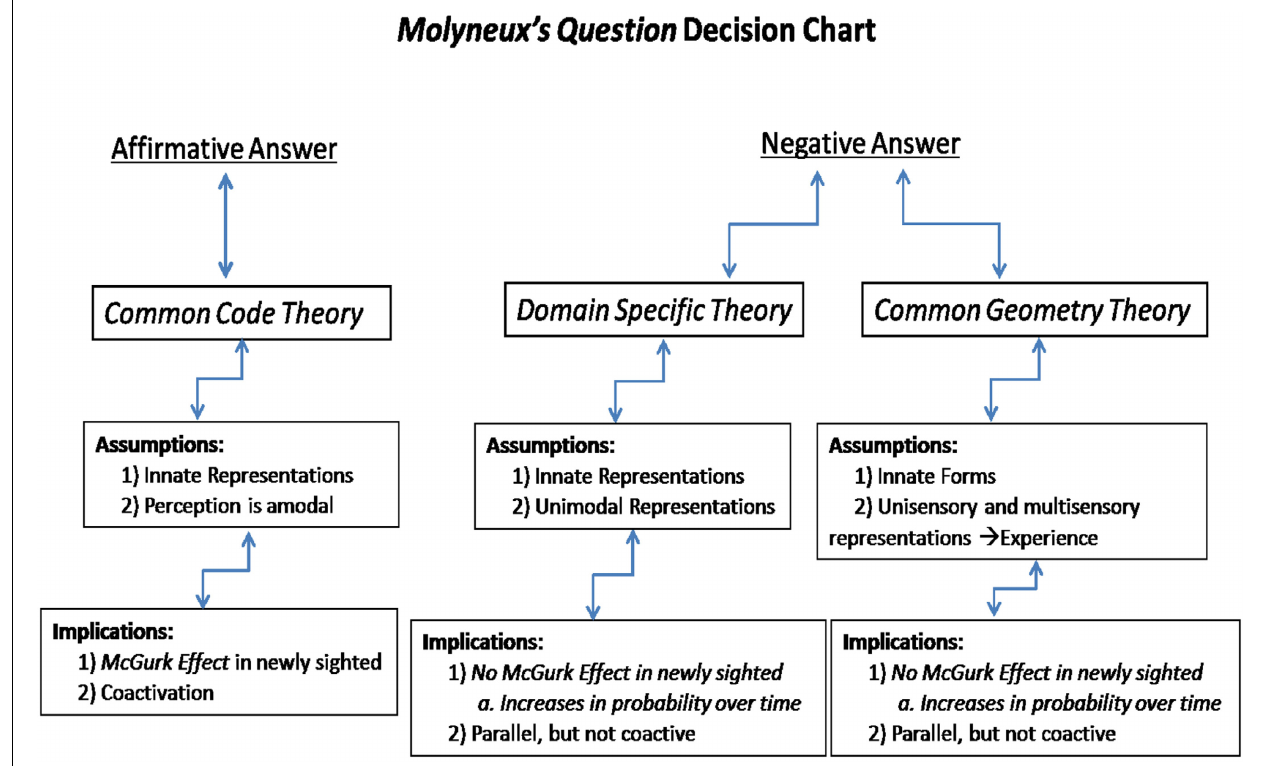
FIGURE 1 | Predictions and features of the three nativist frameworks of multimodal